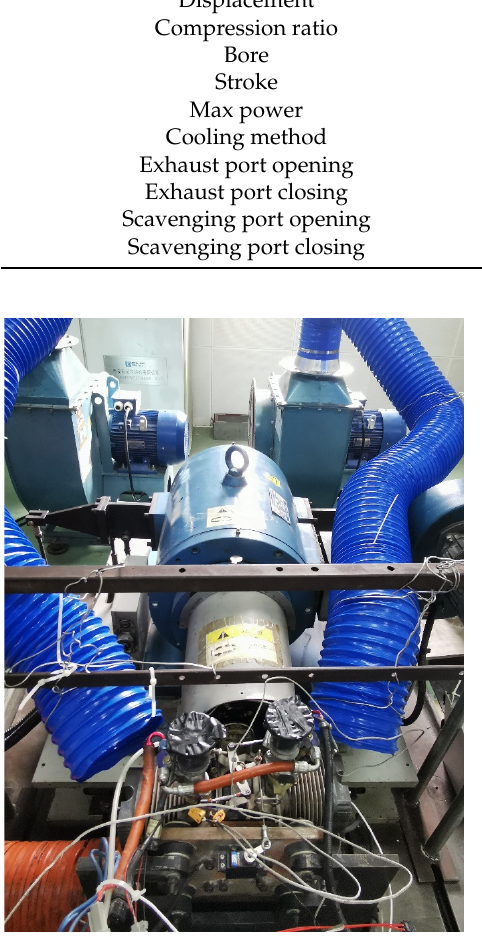
Figure 1. Engine experiment bench.